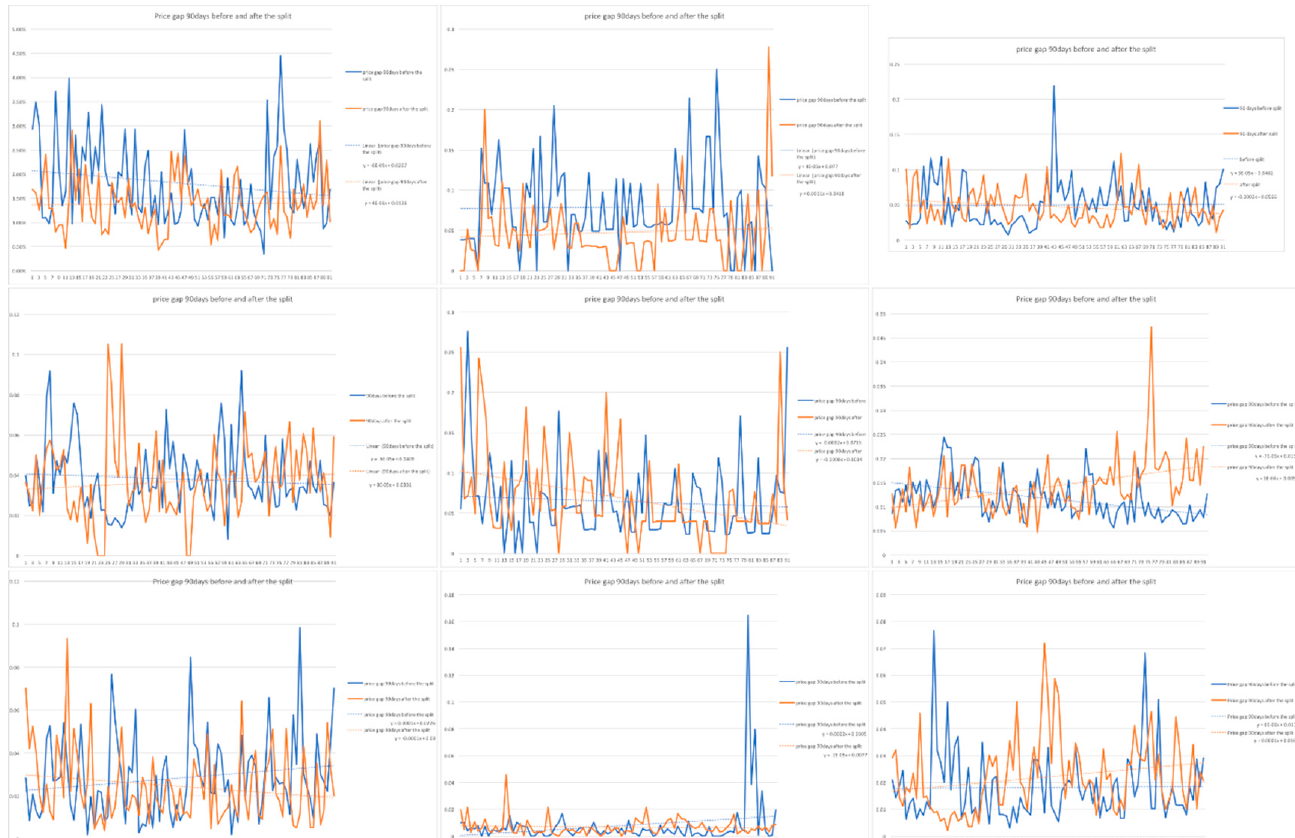
Figure 13 . Price gap over 90 days before and after the split date. The blue line presents the price gap 90 days before the split and yellow line represents the price gap 90 days after the split.